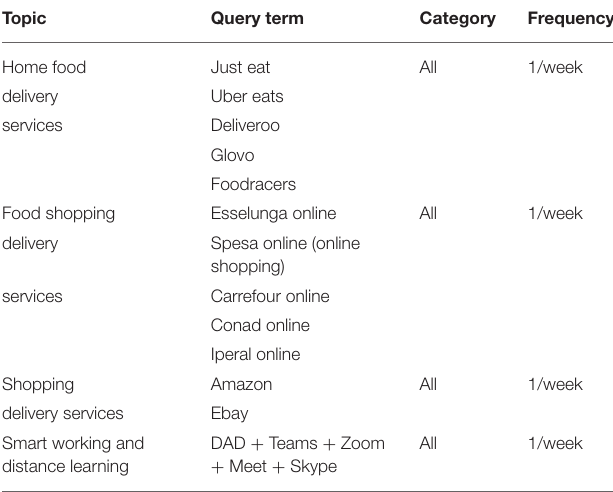
TABLE 1 | Google Trends queries and search